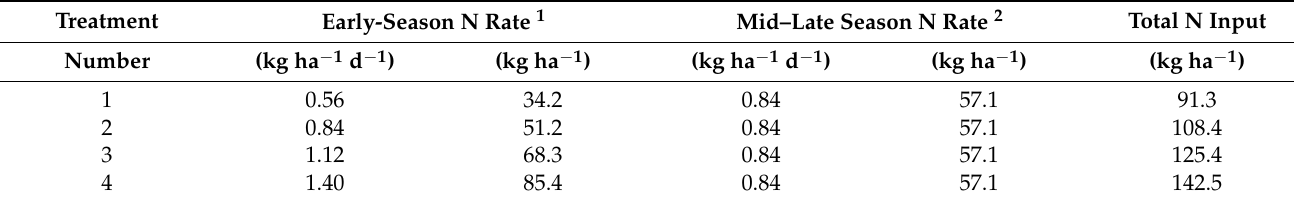
Table 1. Nitrogen (N) fertilization treatments tested for ‘Florida Radiance’ and ‘Florida127’ strawberry in the 2013–2014 growing season. Treatment